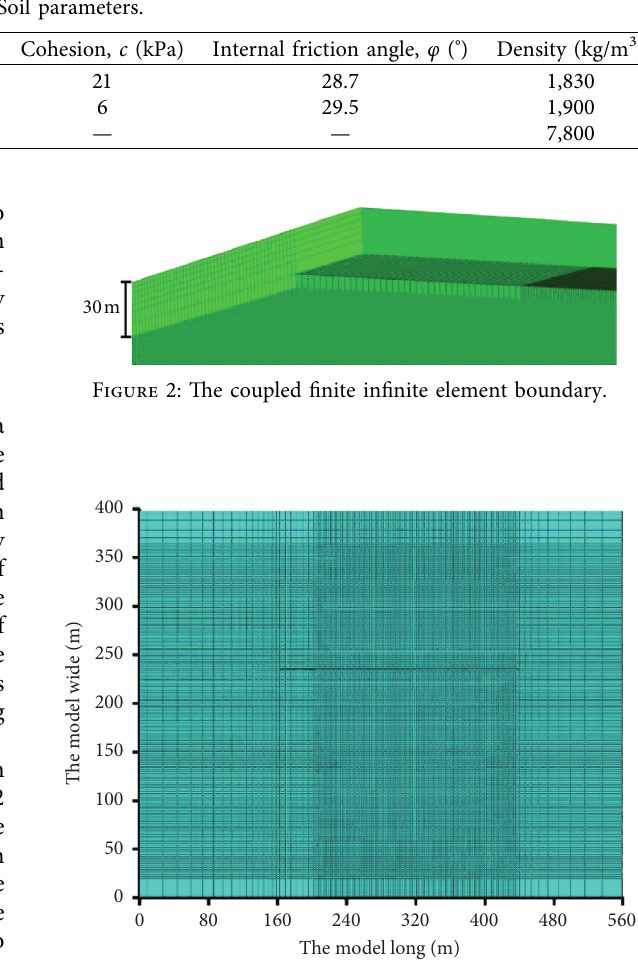
Figure 3: Schematic diagram of the model mesh.